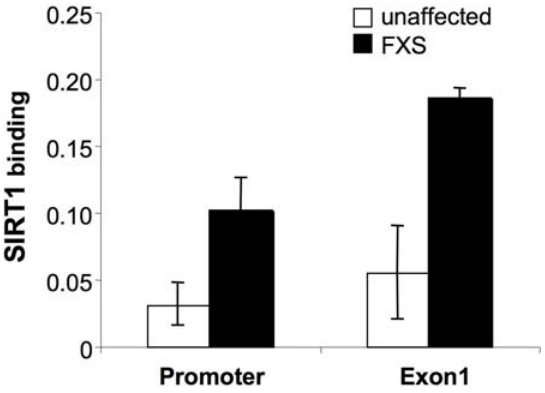
Figure 4. The association of SIRT1 with the FMR1 promoter in unaffected and affected cells. Fibroblasts were transfected with pCruzWTSIRT1-HA which expresses a SIRT-HA tag fusion protein. ChIP was carried out using anti-HA antibody. Real time PCR was carried out on the immunoprecipitated material and the fold change of the FMR1 promoter and the first exon DNA were expressed relative to input DNA.